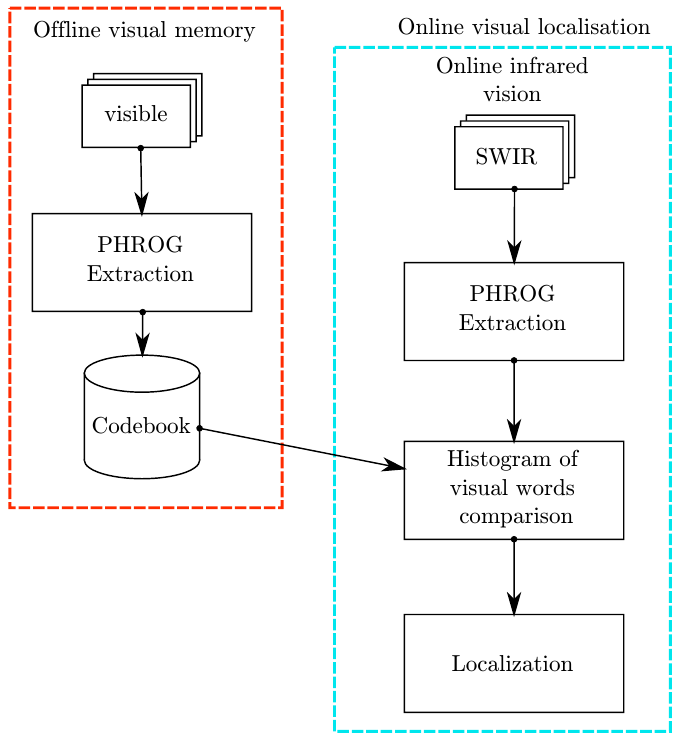
Figure 2. Overview of the method: PHROG features are extracted from a whole sequence considered as the memory and a codebook is computed. Each image from a live sequence is then compared consecutively with other images according to their histogram of visual